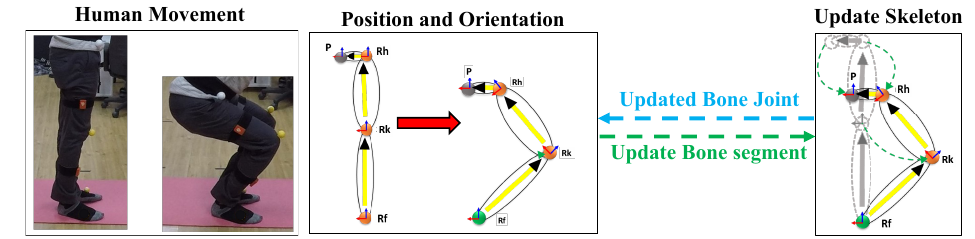
Figure 5. Vector-based right leg bone joint position and orientation